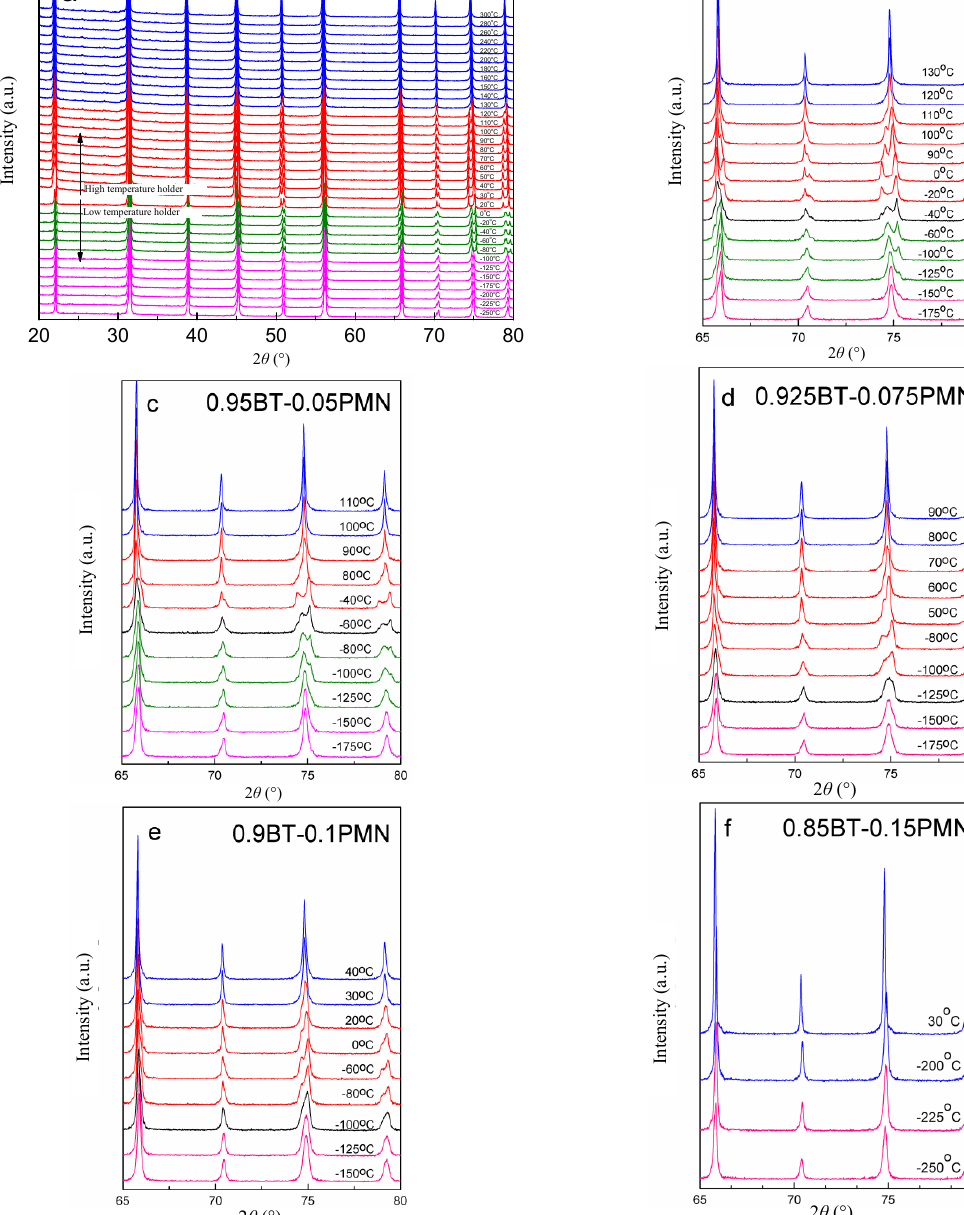
Fig. 2 XRD patterns of (1  x )BT– x PMN ceramics: (a) x = 0, (b) x = 0.025, (c) x = 0.05, (d) x = 0.075, (e) x = 0.1, and (f) x = 0.15. Note that Fig. 2(a) presents XRD pattern in the wide angle range of 20°–80°. For clarity of the presentation, Figs. 2(b)–2(f) show the respective XRD patterns in a narrower angle